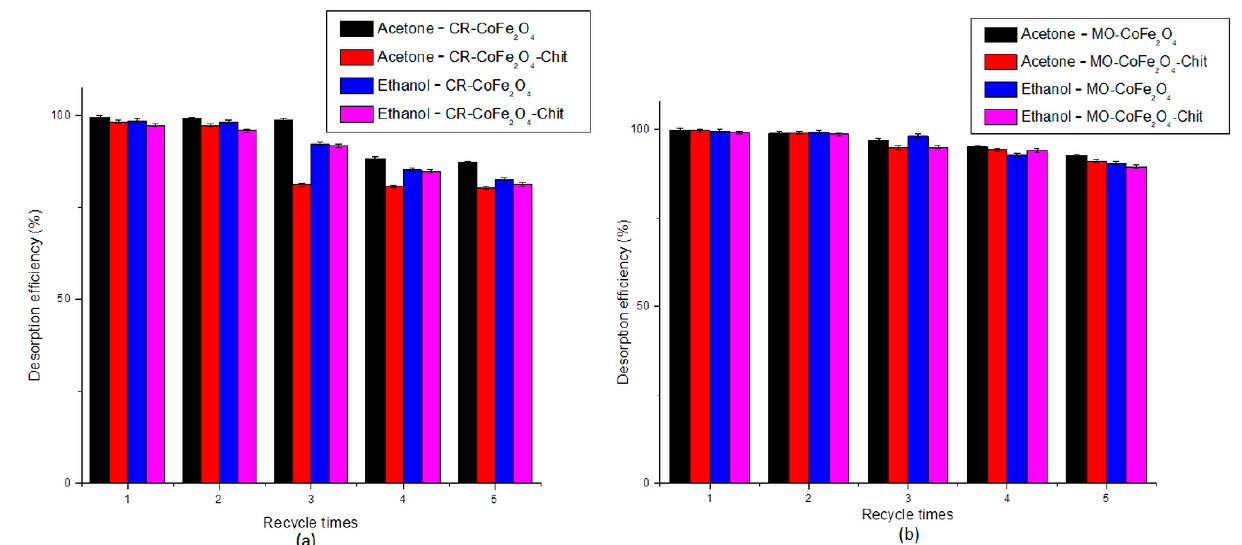
Figure 18. Desorption efficiency of acetone and ethanol for CR ( a ) and MO ( b ).